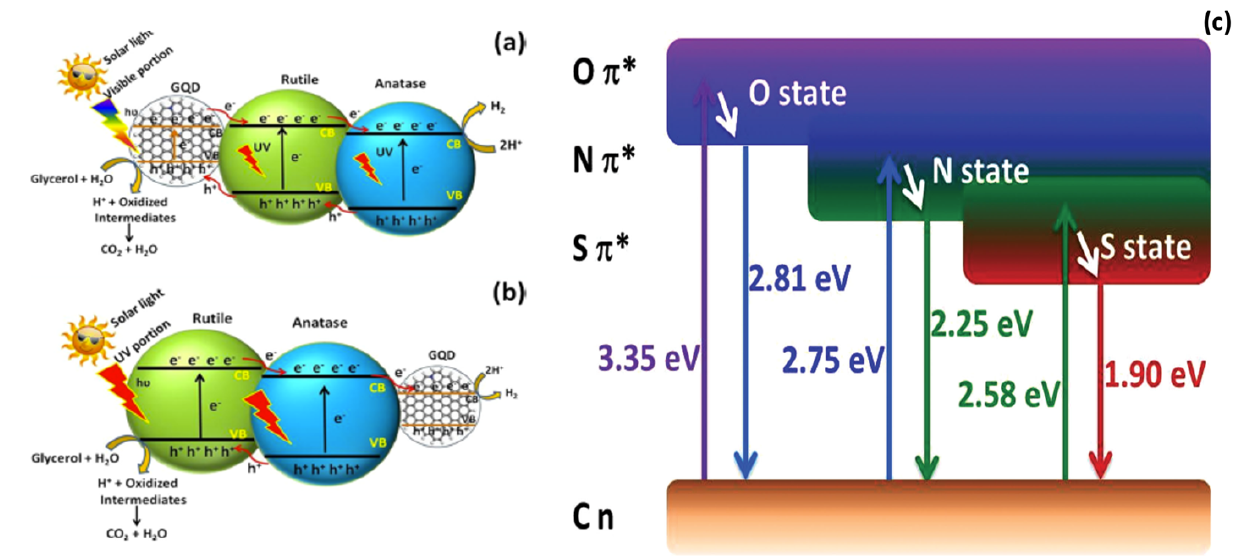
Figure 28. ( a ) Sensitizing effect and ( b ) cocatalytic role of GQDs deposited on biphasic P-25 TiO 2 for improved photocatalytic H 2 evolution under solar light irradiation; ( c ) The proposed energy-level diagram of the S, N-GQDs. ( a ) reprinted with permission from [132]. Copyright @ 2020 American Chemical Society. ( b ) reprinted with permission from [82]. Copyright @ 2015 John Wiley and Sons.